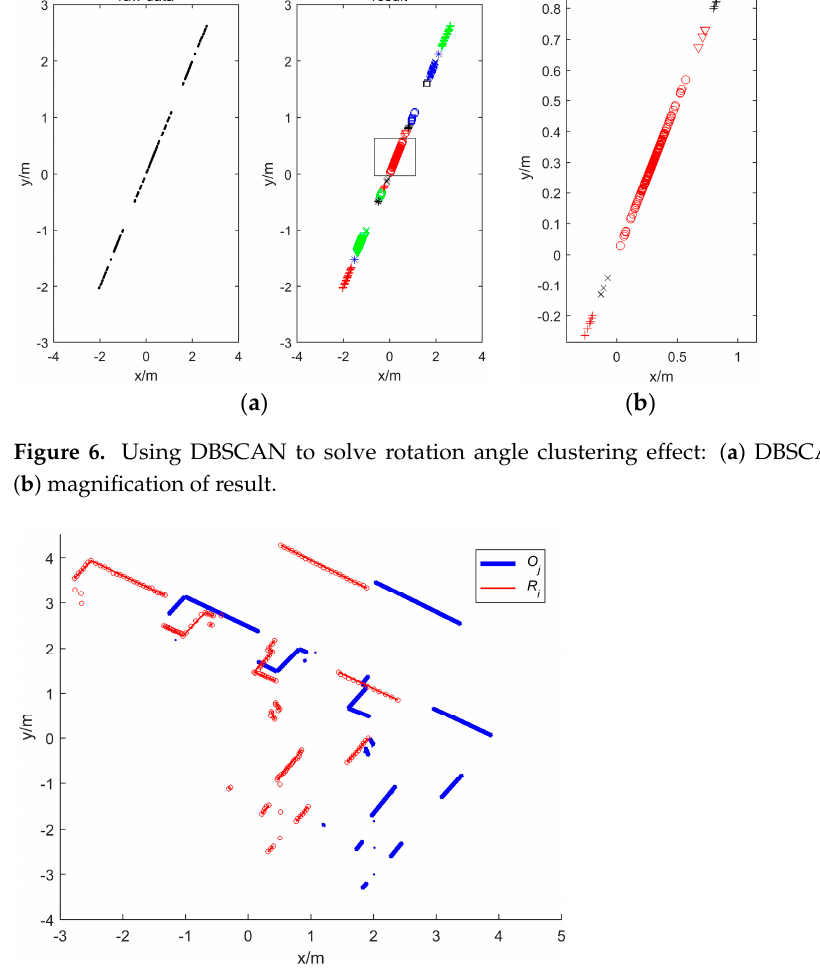
Figure 6. Using DBSCAN to solve rotation angle clustering e ff ect: ( a ) DBSCAN cluster result; ( b ) magni fi cation of result.